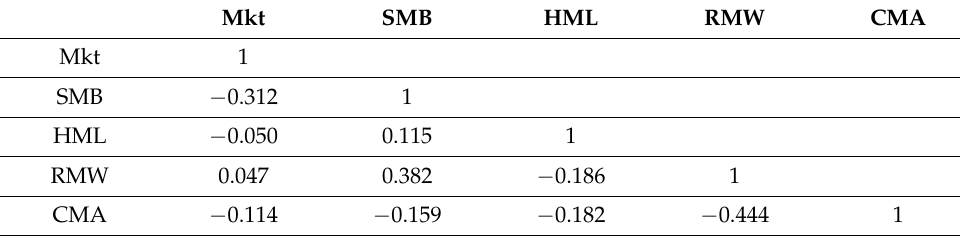
Table 2. Correlations between